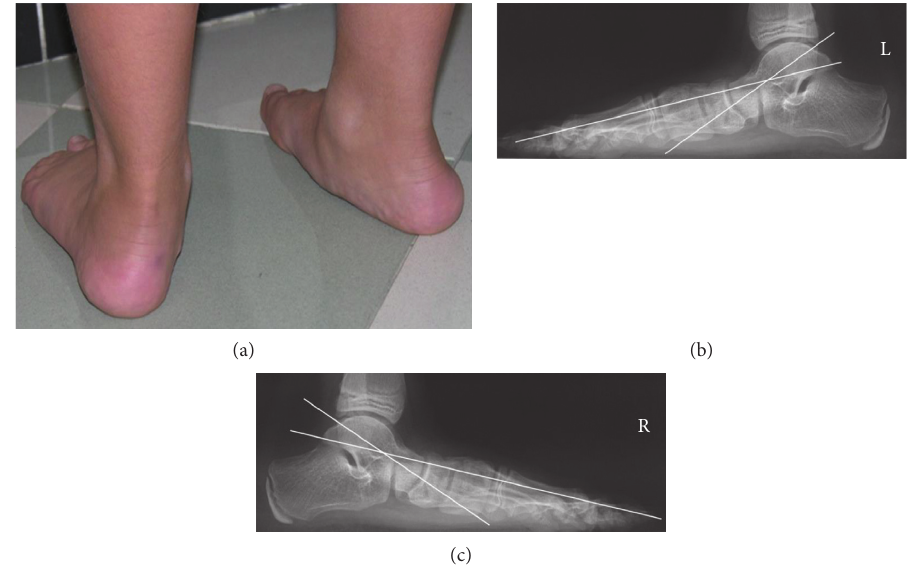
Figure 1: Clinical aspect of an 11-year-old boy with bilateral painful idiopathic flexible flatfoot (a). At radiographic examination, Meary’s angle measured 26 ° of the left foot (b) and 23 ° of the right foot (c). The patient was treated conservatively by an insert sole, but this treatment failed, and a surgical procedure was proposed.